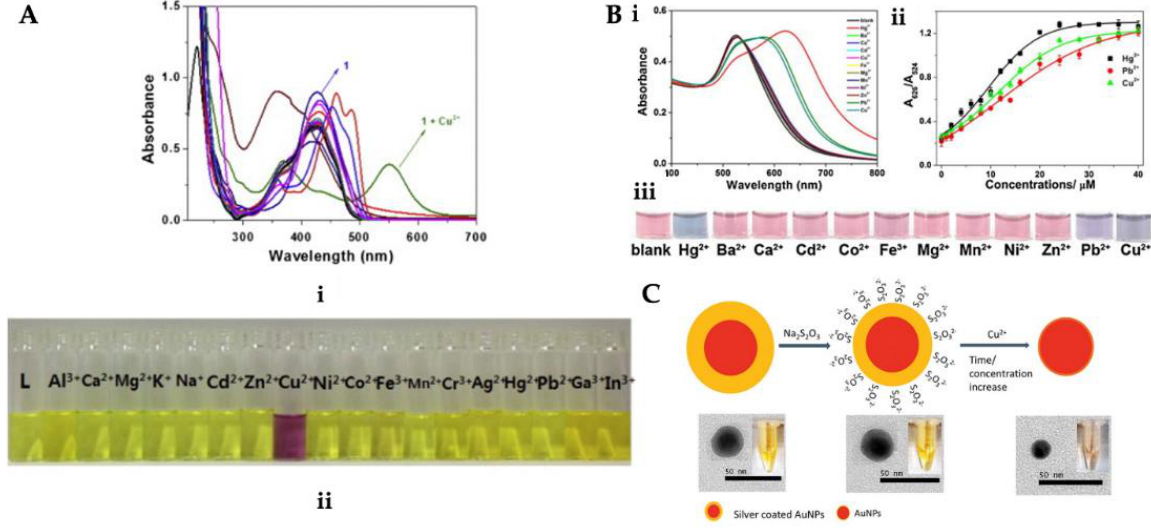
Figure 2. ( i ) Absorption and ( ii ) color changes upon the addition of different metal ions ( A ), ( i ) UV- vis absorption spectra with distinct metal ions, ( ii ) P-AuNPs against several concentrations of Cu 2+ , Hg 2+ , and Pb 2+ ions ( iii ) solution with different metal ions ( B ) and scheme of the Ag/AuNPs for Cu 2+ ion detection ( C ). Republished with permission from [83,86,87].